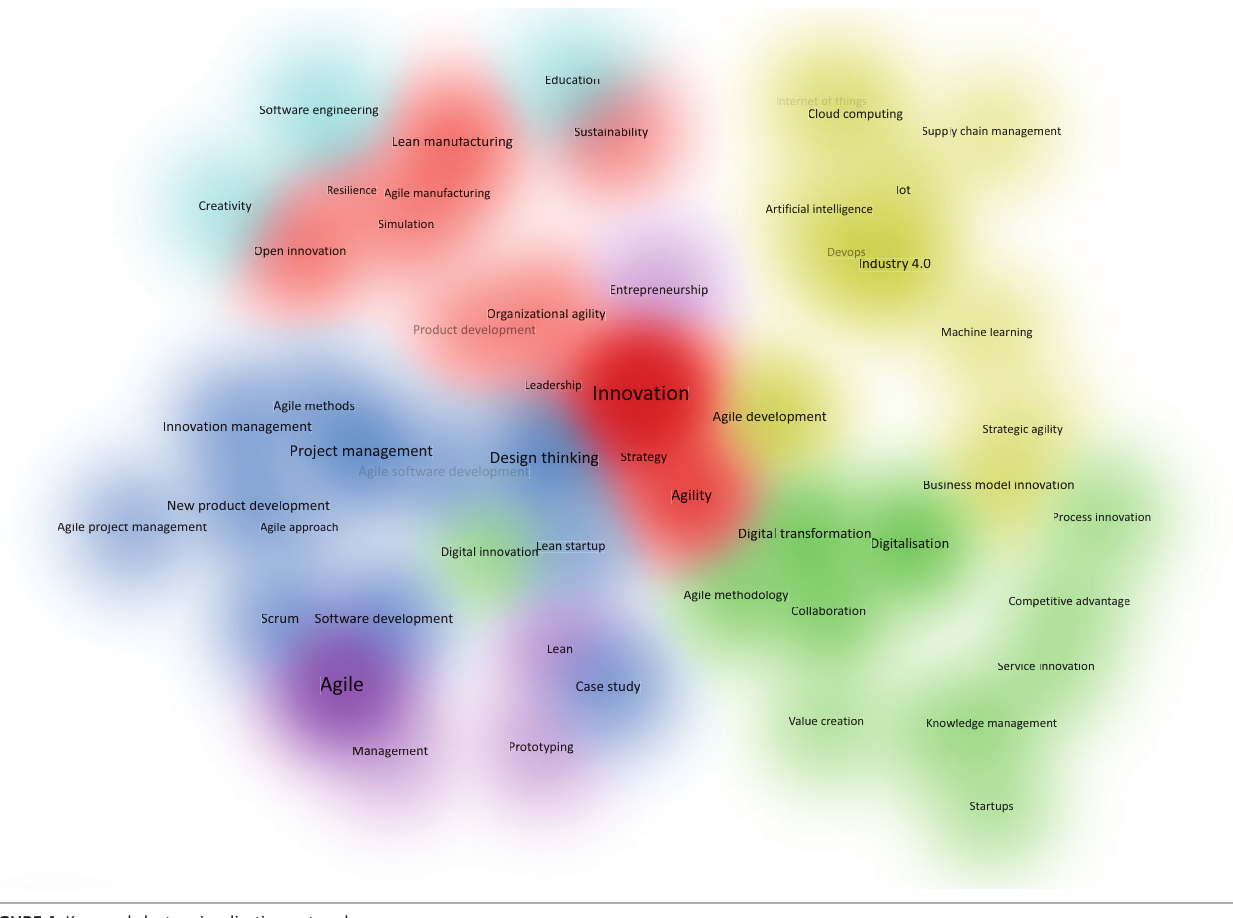
FIGURE 4: Keyword cluster visualisation network.